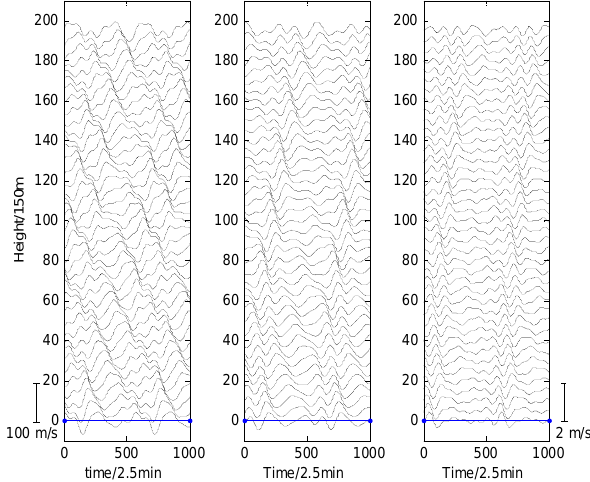
Fig. 6a. Time variations of perturbation velocities at successive heights. Left panel: zonal velocity profile; middle panel: merid- ional velocity profile; right panel: vertical velocity profile. The data were obtained from Eqs. (7a), (7b), (7c) and Table 2a with (A 1 ,A 2 ,A 3 ,A 4 ,A 5 ) = ( 0 . 1 , 0 . 1 , 0 . 1 , 0 . 1 , 0 . 1 ) . The time step is 2.5min and the height resolution is 150m. The horizontal lines indicate 0ms − 1 for the first profile, and successive profiles are 0.75km apart. The velocity scale of zonal and meridional velocities are indicated at the lower left corner of this figure, and the velocity scale of the vertical velocity is indicated at the lower right corner of this figure. These velocity profiles were prepared for wave packet analysis (phase and group velocity tracing technique) and Stokes parameters analysis.